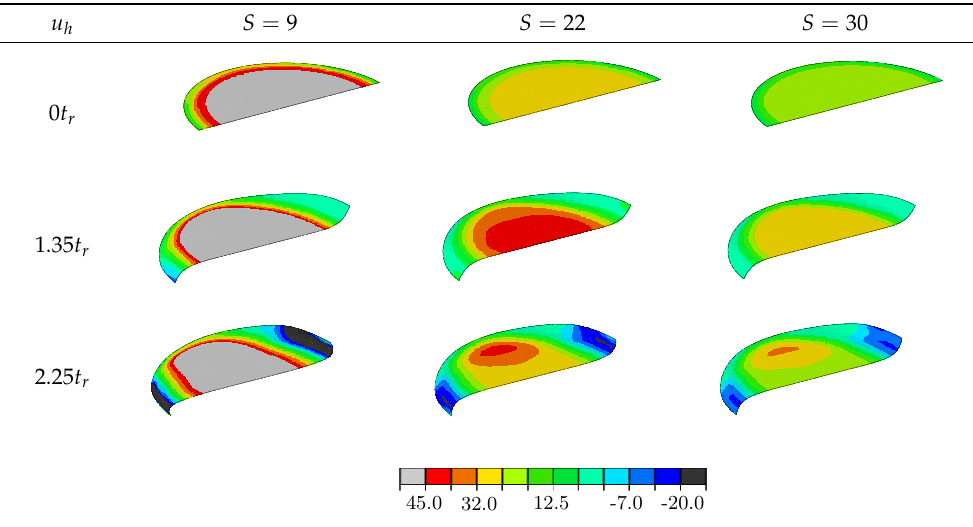
Figure 10. Influence of the factor shape S on the axial stress S11 distribution in the carbon fiber reinforcement.